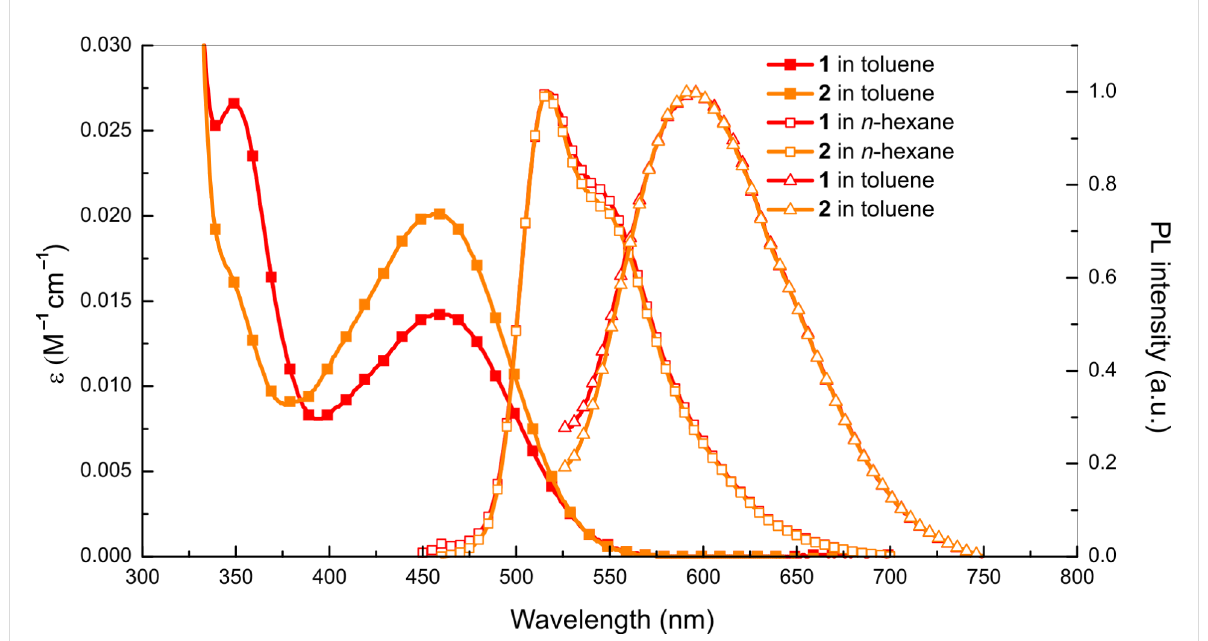
Figure 2: UV–vis (solid point) and photoluminescence (hollow point) spectra of 1 and 2 in dilute solution.